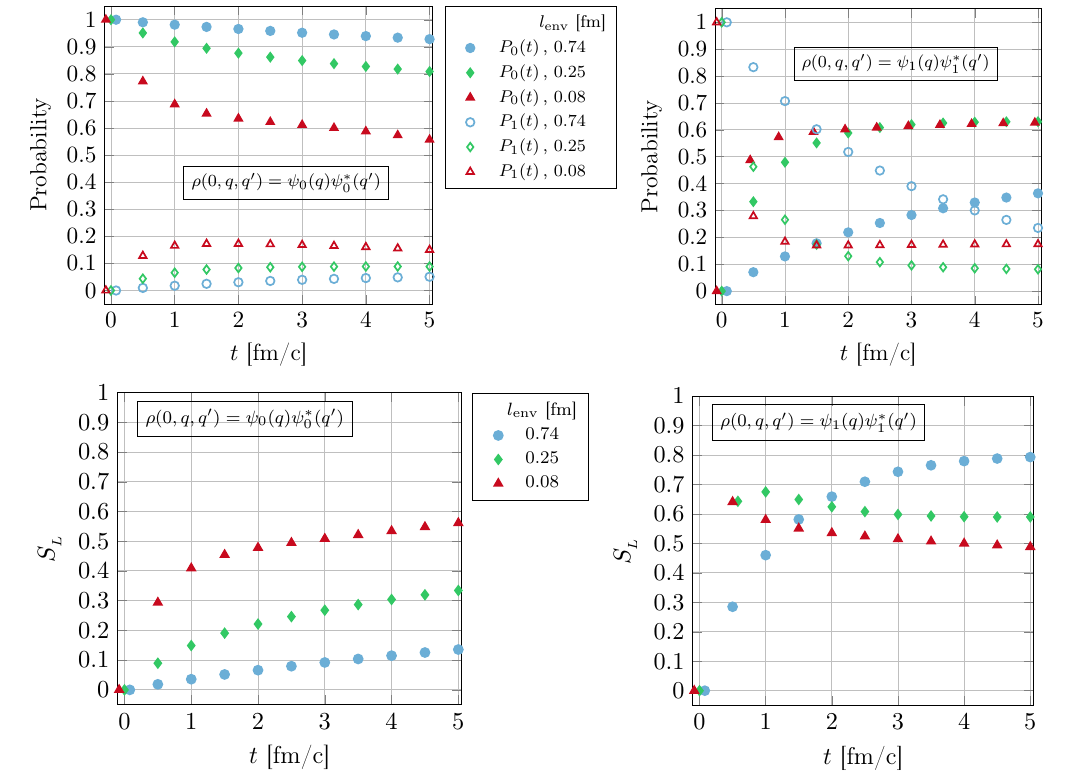
Figure 3 . Top: probabilities P 0 ( t ) ; P 1 ( t ) of having respectively the ground state 0 and the excited state 1 at time t . Bottom: time evolution of the linear entropy. In the left (right) panels the initial density matrix (cid:26) (0 ; q; q 0 ) corresponds to the ground (excited) state. Three di(cid:11)erent correlation lengths of the environment ( l env ) have been considered in order to explore the regimes p l env > l , l < l env < l , l env < l , where l = x 2 with values l = 0 : 162 fm and 1 0 1 0 0 h i l = 0 : 384 fm. In all plots of this paper error bars are much smaller than the symbols representing 1 the data. Some of the points are slightly shifted horizontally to avoid superpositions of